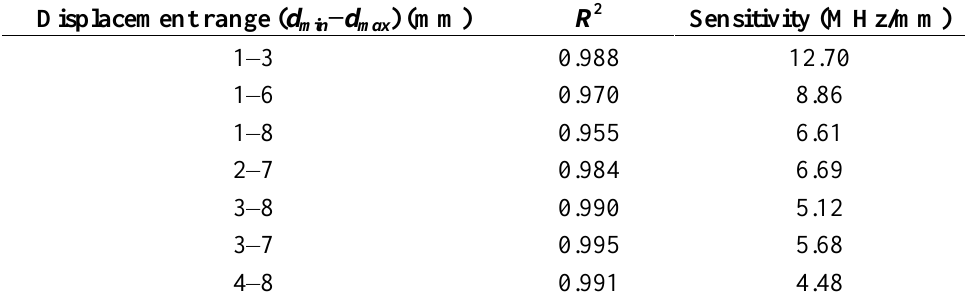
Table 1. Linearity and sensitivity of the displacement sensor: R 2 and sensitivity parameters for several selected displacement